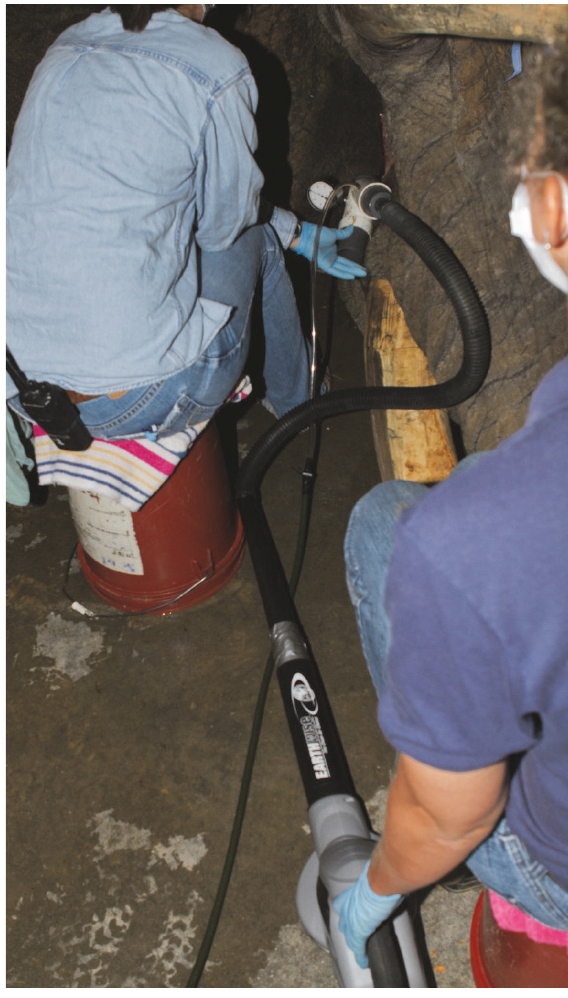
Figure 5: A modified Y-piece apparatus and electric leaf blower were attached to the endotracheal tube to provide intermittent positive pressure ventilation (IPPV) and supplemental oxygen to the elephant bull during the duration of the anesthesia.